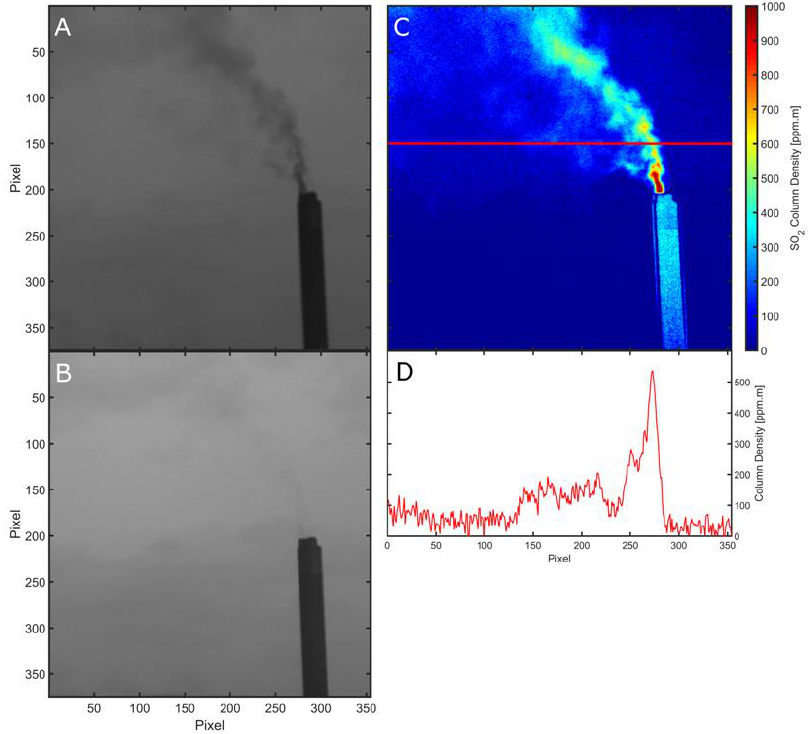
Figure 4. ( A ) A cropped image of the Drax smokestack taken at 310 nm with a shutter speed of 300 ms. The initial image pixels are binned to generate a pixel resolution of 648 × 486, to reduce noise; dark image subtraction and mask corrections have been applied. ( B ) As in (A) but at 330 nm with a shutter speed of 40 ms. ( C ) The resulting calibrated SO 2 image of Drax power station stack and plume showing the clear capacity of the system to resolve the plume emissions. ( D ) A cross-section of (C) showing gas concentrations along the row delineated by the red line. The background noise level can be clearly observed between pixels 300 to 350.